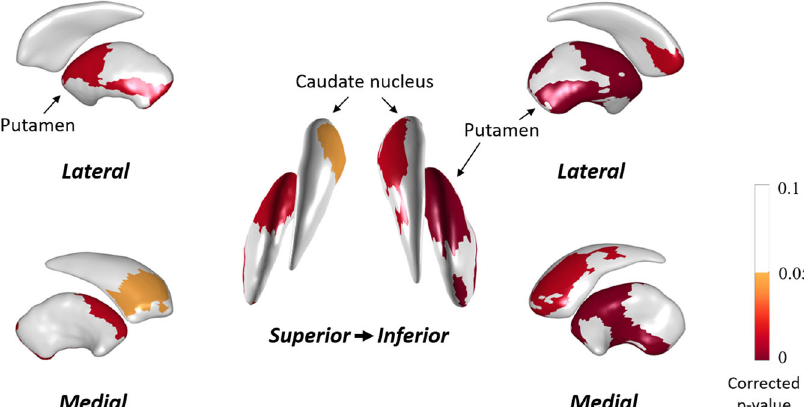
Fig. 1 Statistical maps of the striatal local region that correlates with MR estimates with ICV adjustment. Pearson ’ s correlation analyses showed that bilateral anterior and ventro-posterior putamen and bilateral caudate local volume signi fi cantly correlate with MR estimates. The mapped p values are the results after multiple comparisons correction using cluster-based statistics. Red represents the degree of signi fi cance of correlation coef fi cients.